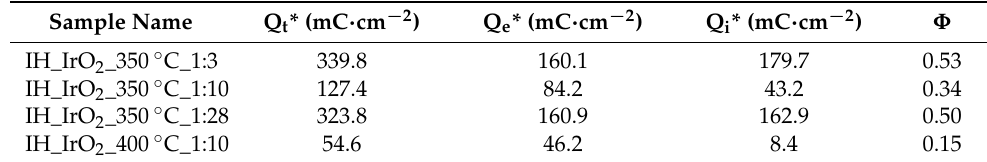
Table 4. Extrapolated results for estimated ECSA and electrochemical porosity.